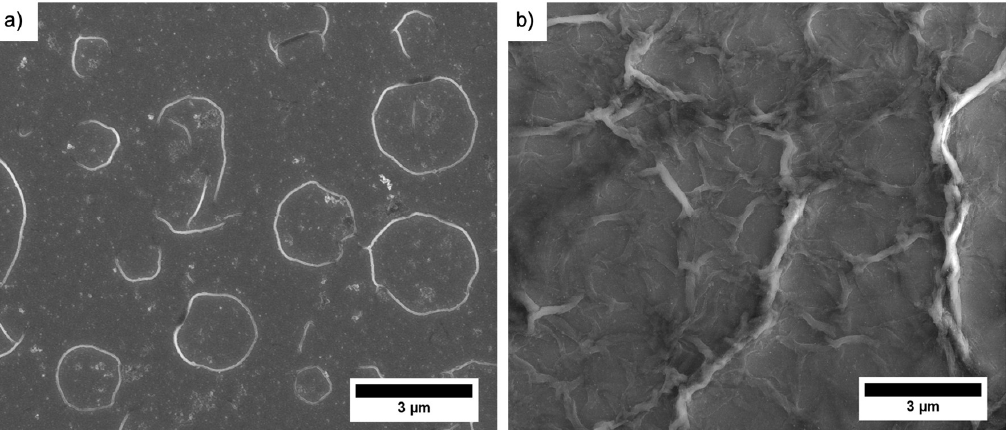
Figure 2. Comparison of film morphology in dependence of electrochemical deposition technique. ( a ) SEM image of a PDA spot deposited via pulse deposition with 10 pulse cycles; ( b ) PDA spot